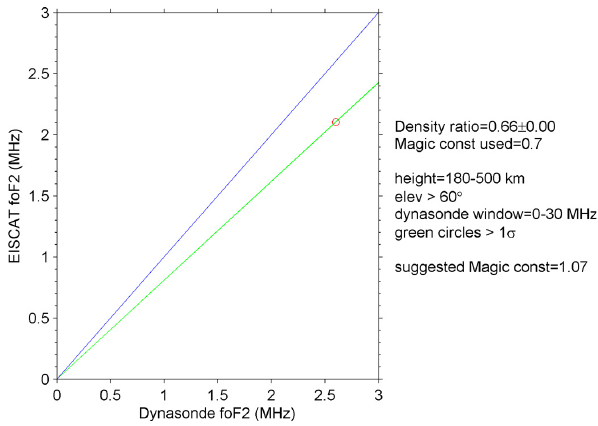
Fig. 1. Calibration of EISCAT electron density profiles by means of ionosonde measurements, according to the algorithm CALIB